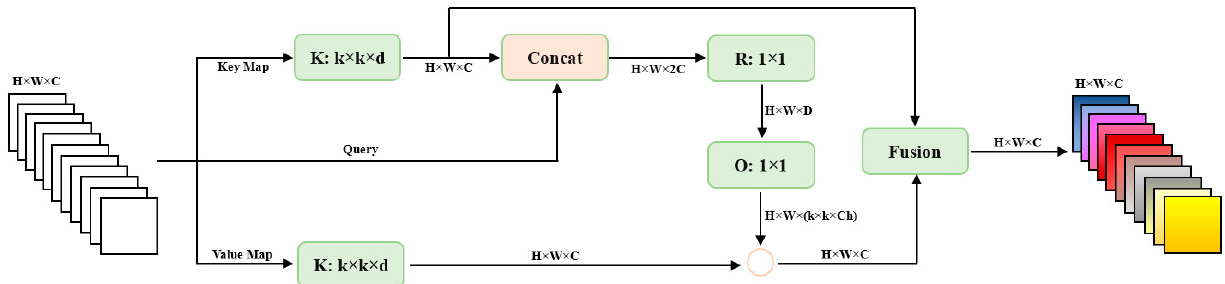
Figure 2. The detailed structures of DCoTNet.